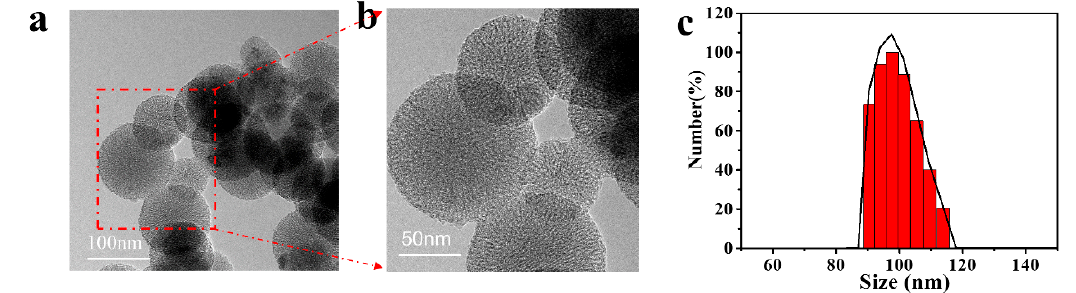
Figure 4. ( a , b ) TEM images, ( c ) size distribution of the MSCNs.